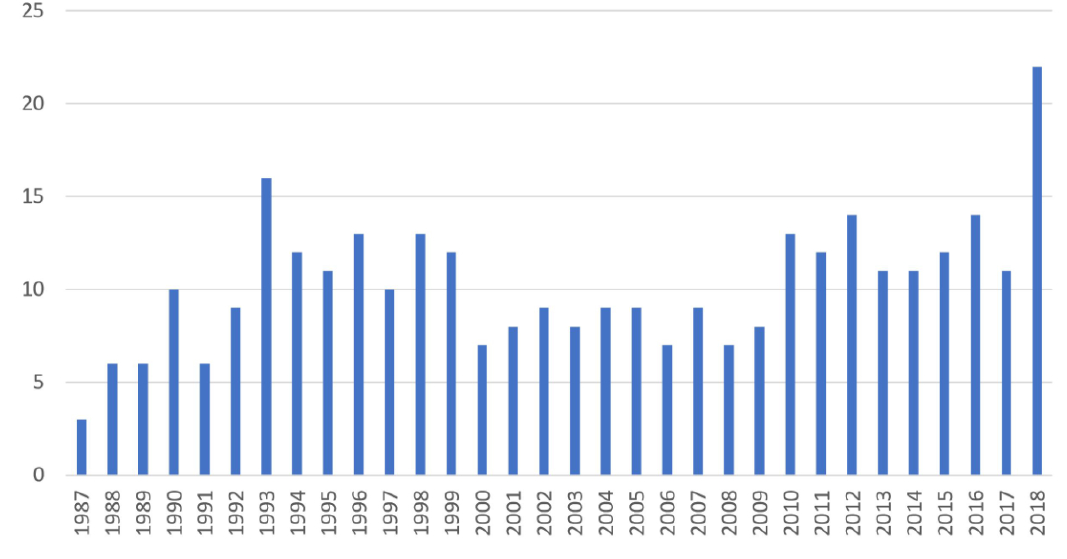
Table S1 : Kaplan-Meier estimate of 1-year mortality of patients surviving at 1 year post-transplant (n = 270, 97 events). Time after transplantation % Survival Patients at risk